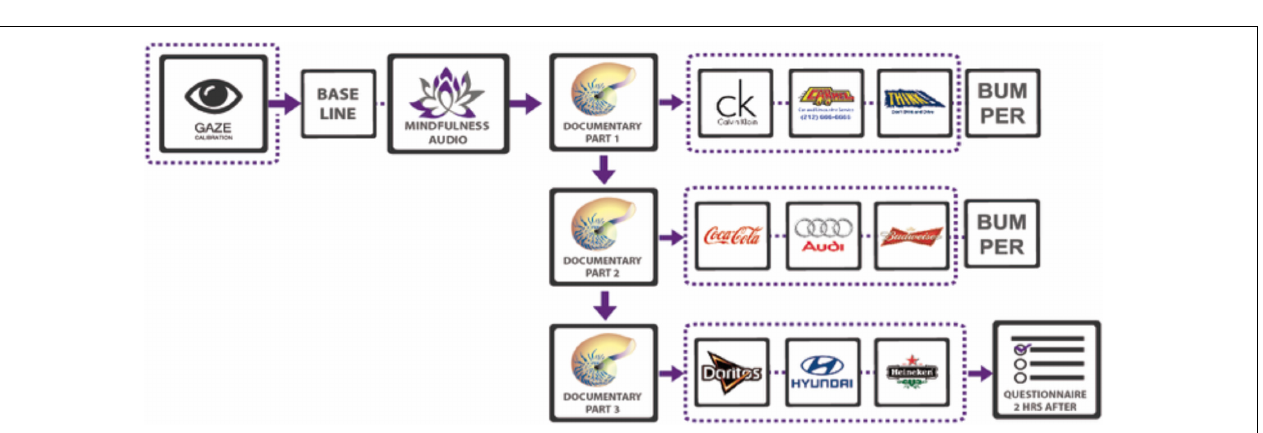
FIGURE 1 | Participant in the study. ( Top : The EEG cap is visible. ECG electrodes placed on the chest and TMSI equipment). ( Bottom : Eye tracking equipment is shown).